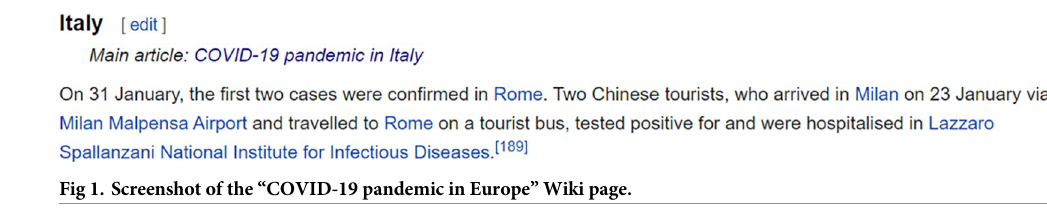
but it also is overseen by a volunteer editor. Unlike other official data sources, such as The Johns Hopkins Coronavirus Resource Center and The Program for Monitoring Emerging Dis- eases (Promed), Wikipedia includes more recent and detailed information about the spread of this deadly disease at (https://en.wikipedia.org/wiki/COVID-19_pandemic_by_country_and_ territory). We collected unstructured data manually and extracted the dates of the first cases